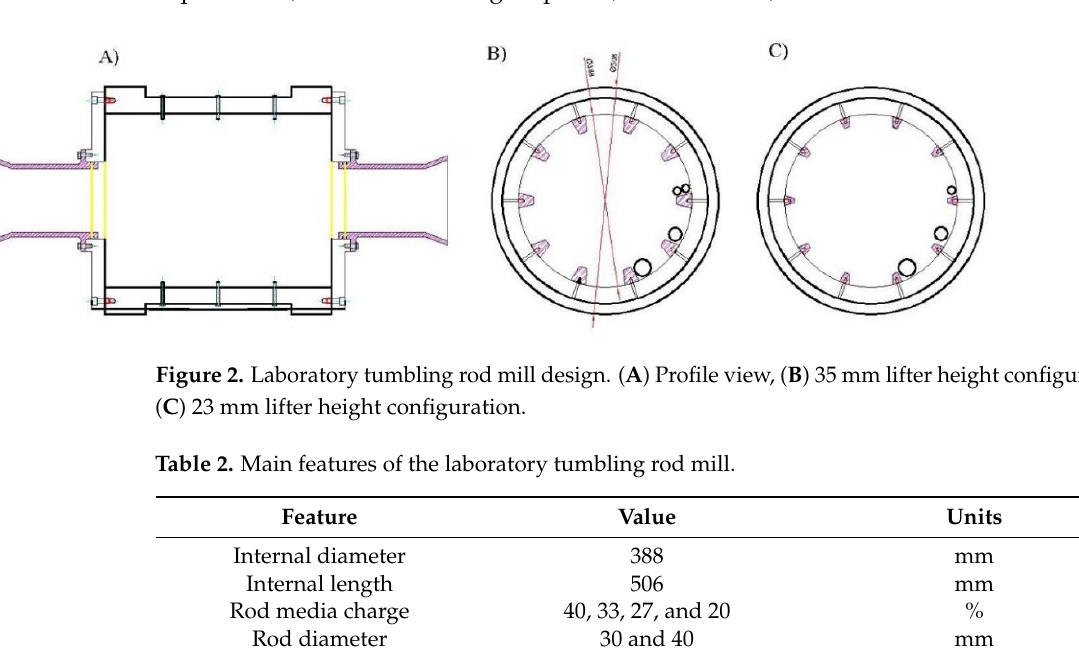
Table 2. Main features of the laboratory tumbling rod mill .